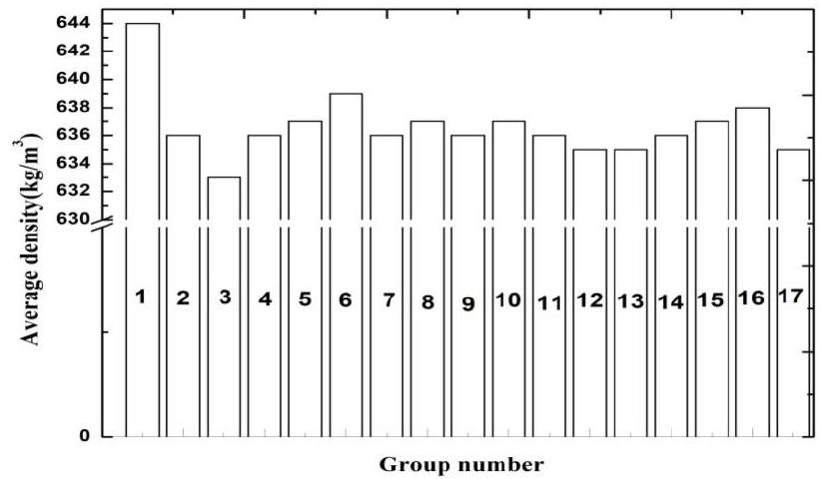
Figure 1. Density distribution of each